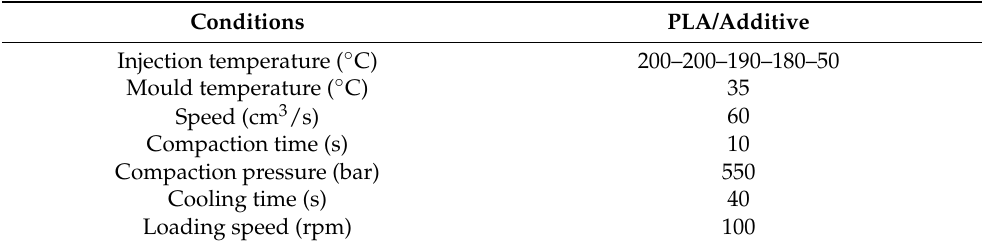
Table 2. Injection moulding conditions of PLA/vinyl acetate